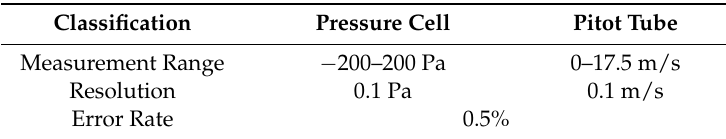
Table 1. Performance and specifications of the differential pressure gauge.